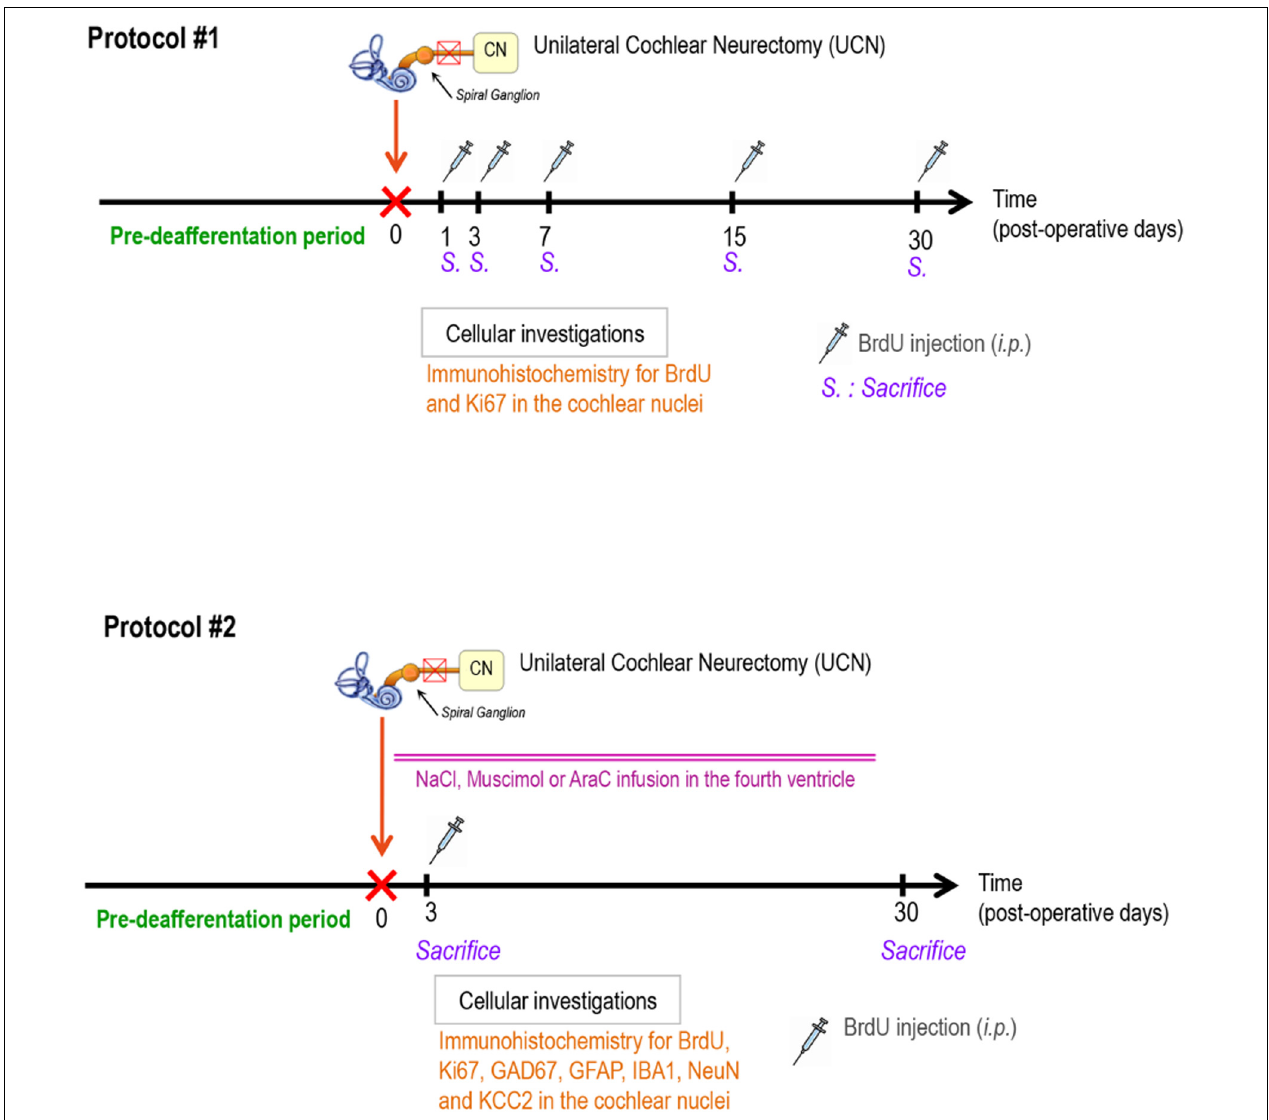
FIGURE 1 | Study designs. The first protocol (#1) was elaborated using BrdU and Ki67 as cell proliferation markers to study the time-dependent effect of a UCN on reactive cell proliferation in cochlear nuclei. Protocol number 2 (#2) was designed using a continuous infusion of NaCl, AraC, or Muscimol in the fourth ventricle to examine alterations in newborn cell survival (BrdU marker), astrogenesis (GFAP marker), GABA cells (GAD67 marker), neuronal cells (NeuN marker), and microglial cells (IBA1 marker) in the cochlear nuclei. BrdU, 5-bromo-2 (cid:48) deoxyuridine; i.p., intraperitoneal injection; GAD67, glutamic acid decarboxylase; GFAP, glial fibrillary acidic protein; CN, cochlear nuclei; n = 4 animals per